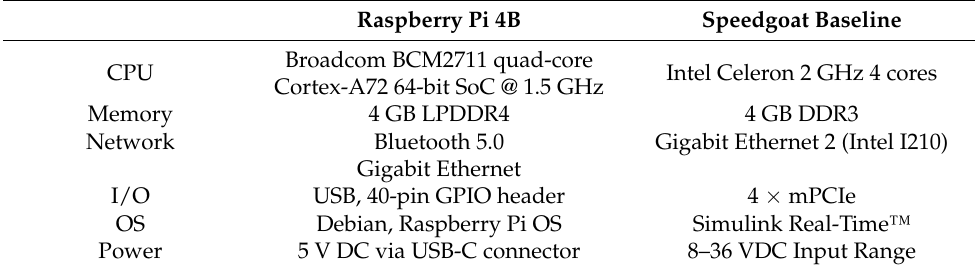
Table 2. Hardware technical specifications.